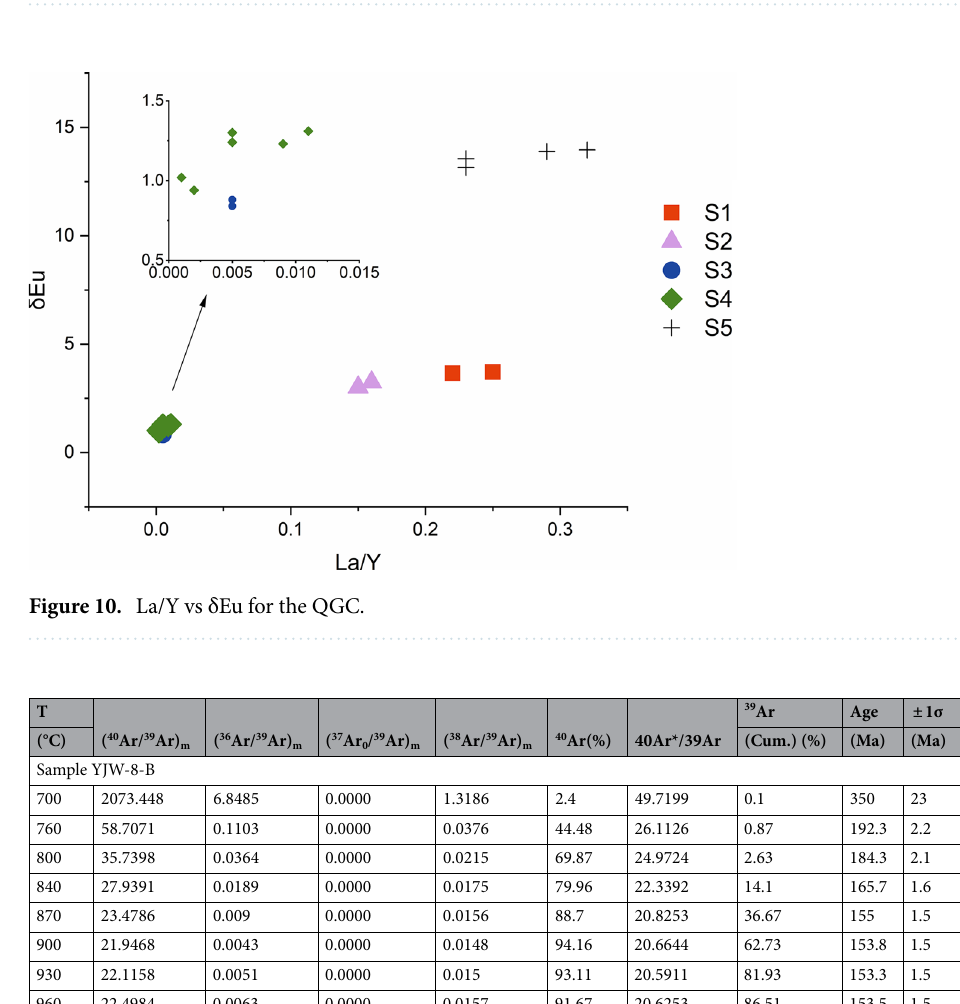
Figure 9. REE patterns for the QGC.